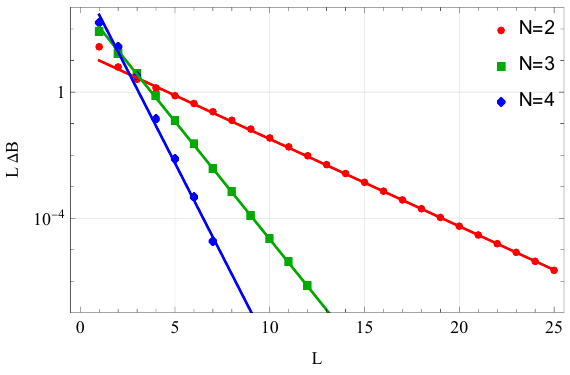
Figure 1. The energy shift ∆ B N due to the finite volume, multiplied by the box size L , as a function of L for the bosonic case, in natural units. Shown are results for dimer (red), trimer (green), and tetramer (blue). The symbols represent SVM results, while the curves are the the Lüscher-like formulae, Eqs. (1,2) using free-space A N and κ N values.